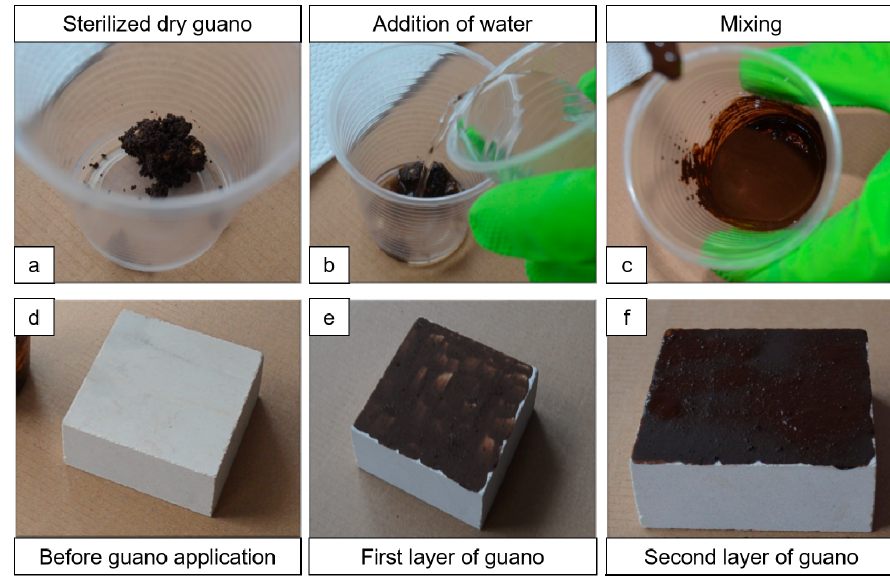
Figure 2. Procedure for guano application: sterilized dry guano ( a ) is added with water ( b ); after mixing ( c ), stone specimens ( d ) are covered with the first layer of guano ( e ) applied by brush; after about 2 min, the second layer of guano ( f ) is applied.